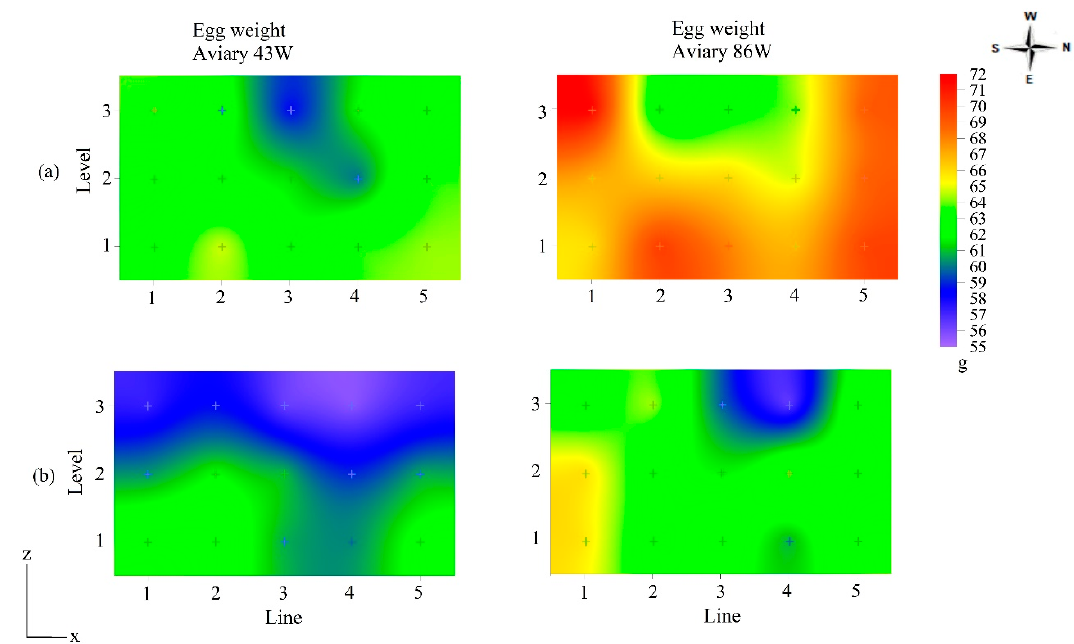
Figure 4. Spatial distribution of egg weight in two aviaries with 43 and 86 week-old hens, for winter ( a ) and summer ( b ).